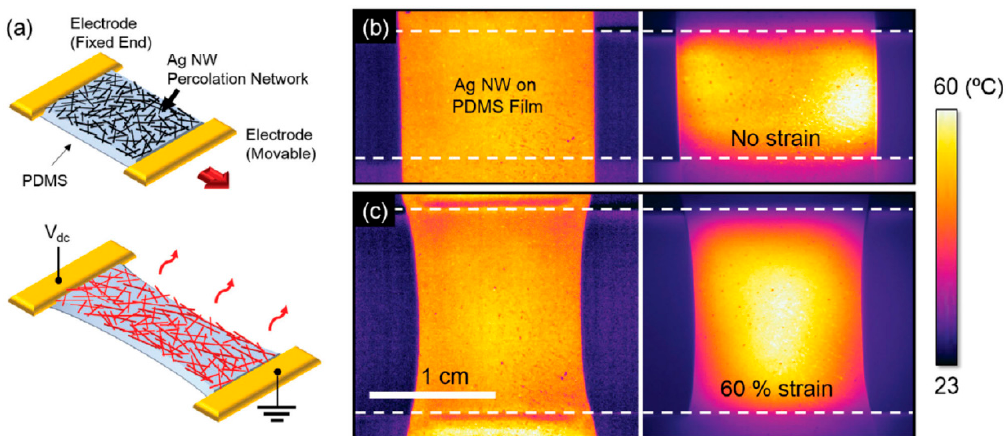
Figure 8. Highly stretchable and transparent heater. ( a ) Schematic illustration of the stretchable and transparent heater composed of an Ag NW percolation network on PDMS film, ( b , c ) pseudocolor image at room temperature (left) and infrared camera thermal image (right) of an Ag NW/PDMS stretchable and transparent heater operating at 60 °C with ( b ) no strain and ( c ) at 60% strain condition. Reproduced from Ref. [108] with permission. Copyright 2015, John Wiley and Sons.